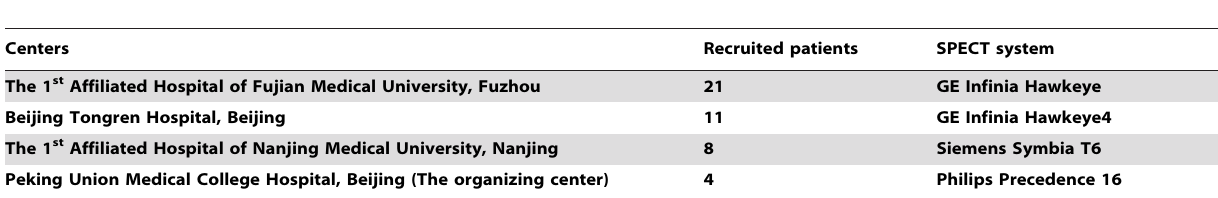
Table 1. The recruited patient number and SPECT systems of the 4 centers.